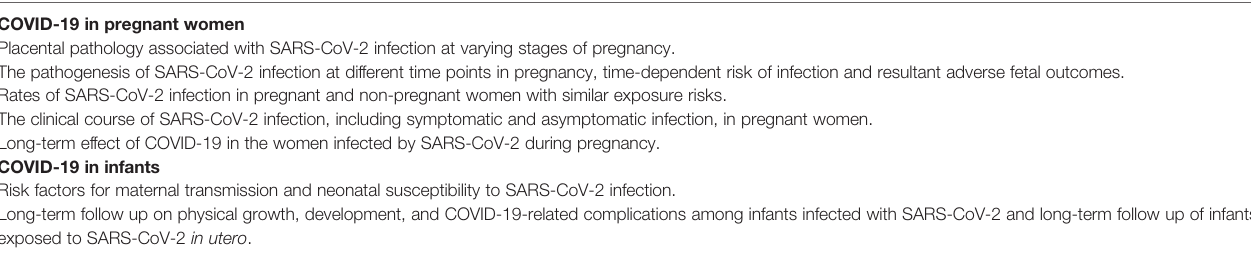
TABLE 1 | Consensus on priorities for future research related to COVID-19 in pregnant women and infants. COVID-19 in pregnant women Placental pathology associated with SARS-CoV-2 infection at varying stages of pregnancy. The pathogenesis of SARS-CoV-2 infection at different time points in pregnancy, time-dependent risk of infection and resultant adverse fetal outcomes. Rates of SARS-CoV-2 infection in pregnant and non-pregnant women with similar exposure risks. The clinical course of SARS-CoV-2 infection, including symptomatic and asymptomatic infection, in pregnant women. Long-term effect of COVID-19 in the women infected by SARS-CoV-2 during pregnancy. COVID-19 in infants Risk factors for maternal transmission and neonatal susceptibility to SARS-CoV-2 infection. Long-term follow up on physical growth, development, and COVID-19-related complications among infants infected with SARS-CoV-2 and long-term follow up of infants exposed to SARS-CoV-2 in utero